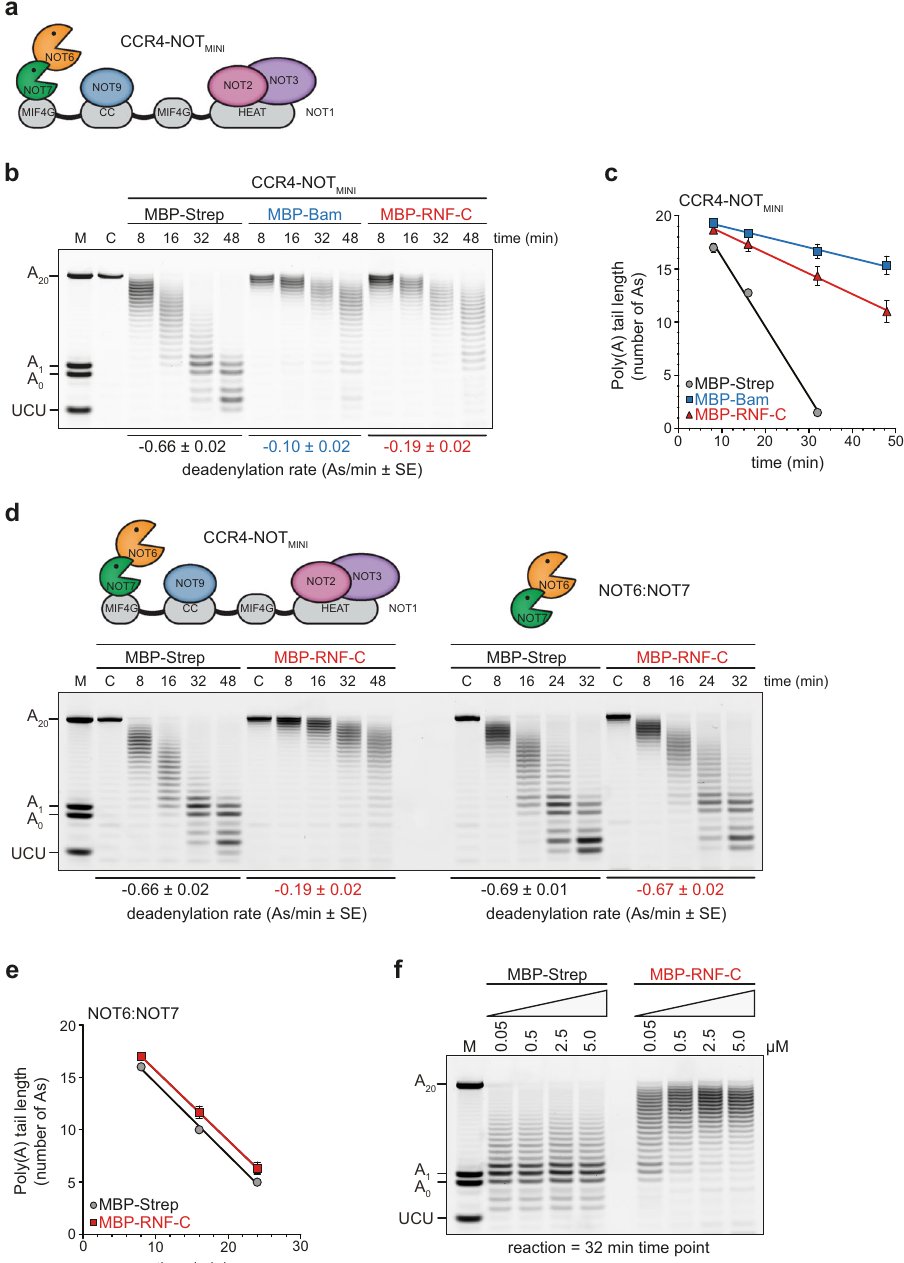
Fig. 4 RNF219 inhibits CCR4-NOT-mediated deadenylation in vitro. a Scheme representing the architecture of the recombinant CCR4-NOT MINI complex; MIF4G, middle domain of eukaryotic initiation factor 4G; CC, coiled-coil. b In vitro deadenylation assay with 50 nM of a 7-mer-A 20 RNA substrate, 50 nM CCR4-NOT MINI complex, and 2250 nM of either MBP-Strep, Dm MBP-Bam Caf40-binding motif (residues 13-36) or MBP-RNF219-C. Reactions were stopped at the indicated time points and analyzed by electrophoresis using a 20% denaturing polyacrylamide gel; M, RNA size marker; C, RNA alone control. c Quanti fi cation of the change in poly(A) tail length in ( b ) by plotting the most abundant tail length at each time point. Linear regression was used to determine the apparent deadenylation rate (As/min); values are presented as mean ± SE ( n = 3). d In vitro deadenylation assay with 50 nM of a 7-mer- A 20 RNA substrate, 50 nM CCR4-NOT MINI complex (left) or 250 nM NOT6:NOT7 exonuclease heterodimer (right), and 2250 nM of MBP-Strep or MBP- RNF219-C. Reactions were stopped at the indicated time points and analyzed as described in ( b ). e Quanti fi cation of the change in poly(A) tail length in ( d ) by plotting the most abundant tail length at each time point; values are presented as mean ± SE ( n = 3). f In vitro deadenylation assay with 50 nM of the 7- mer-A 20 RNA and 50 nM of the CCR4-NOT MINI complex. MBP-Strep alone or MBP-RNF219-C were titrated into the reaction (0.05 – 5.0 µ M). Reactions were stopped after 32 min. Source data for panels ( b – f ) are provided as a Source Data fi